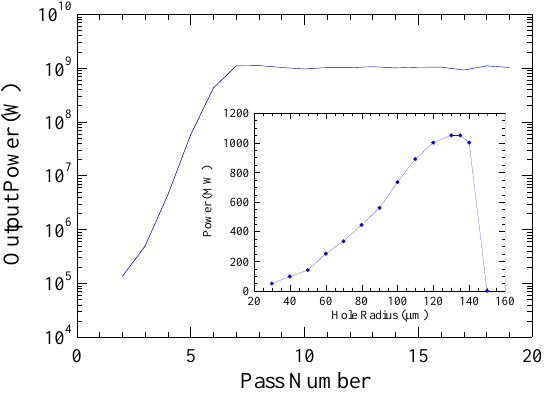
Figure 22. Output power versus number of passes through the resonator for a whole radius of 135 µm. The inset shows the output power as a function of hole radius. Other simulation parameters are described in the